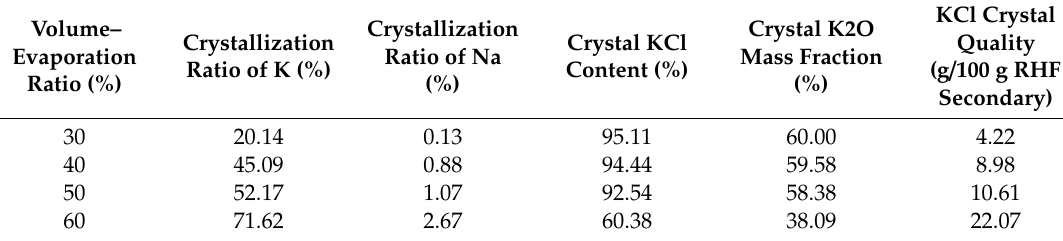
Table 8. Experimental results under di ff erent volume evaporation